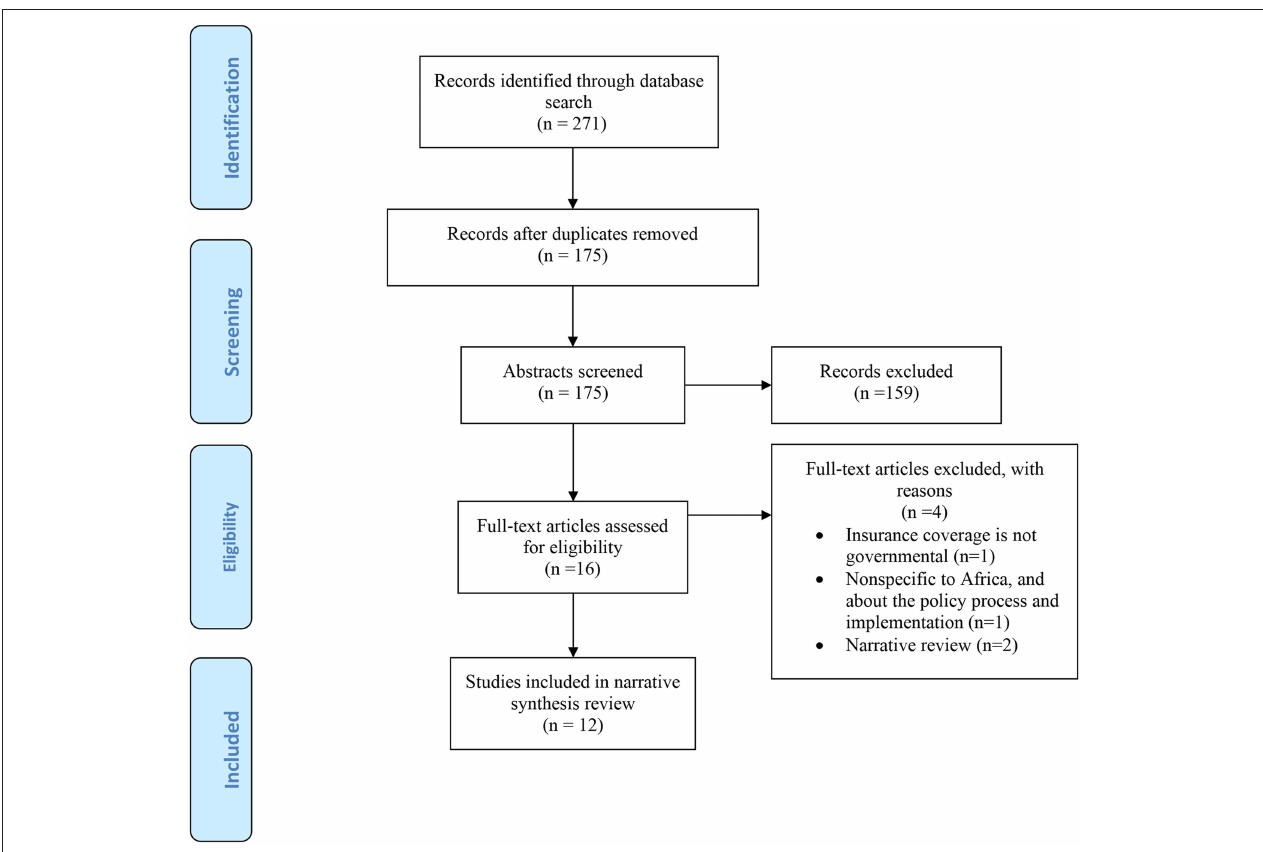
FIGURE 1 | Flow diagram of study selection